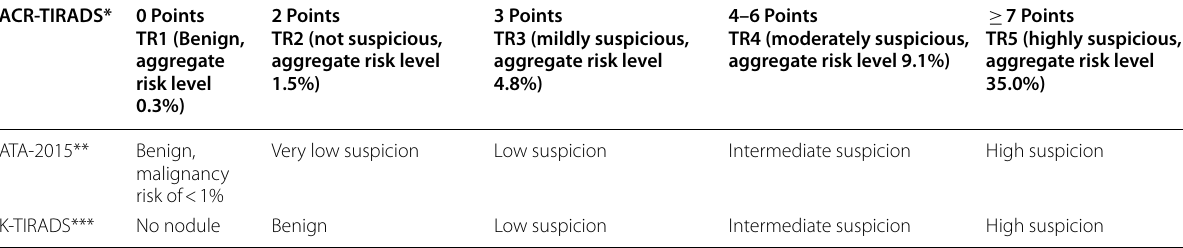
*American College of Radiology—Thyroid imaging reporting and data system **American Thyroid Association ***Korean thyroid imaging reporting and data system